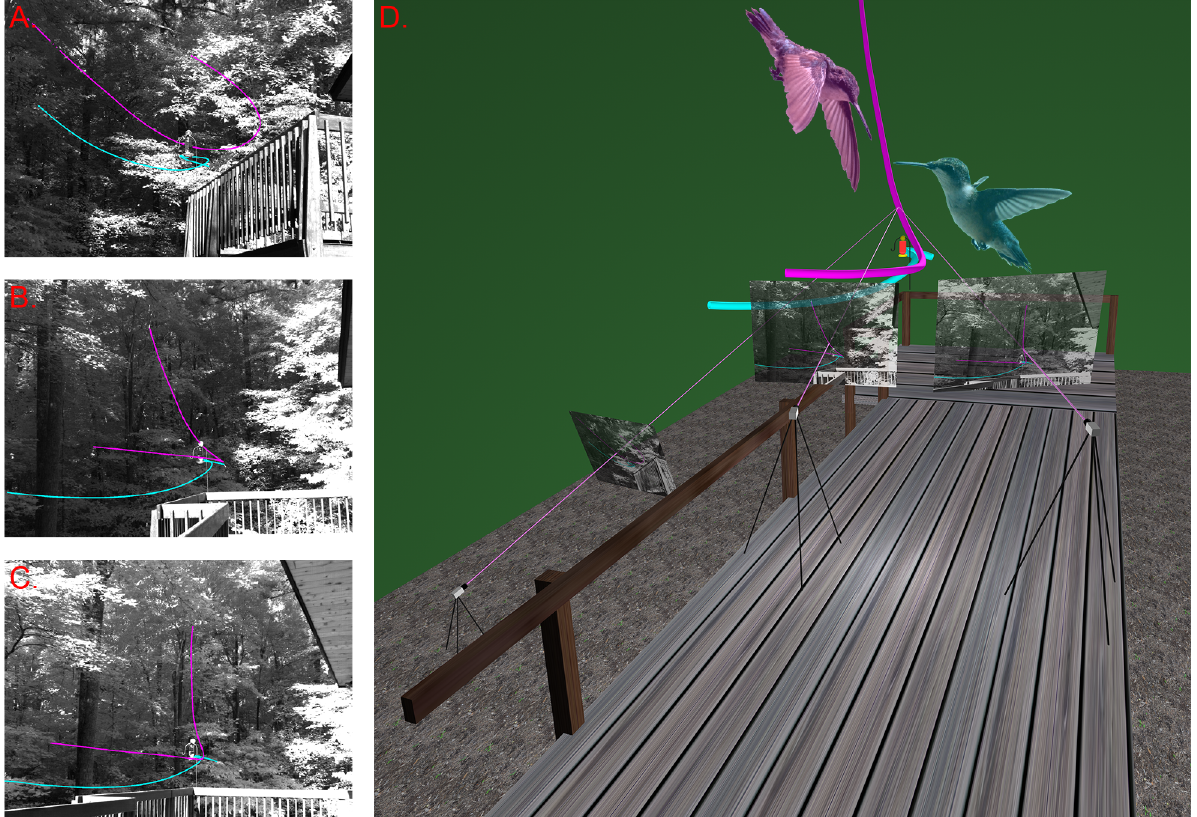
Fig 1. Video recording setup and example flight trajectories. Panels A-C show images from each of the three cameras in a recording setup; panel D shows a reconstruction of the 3D scene including the cameras, their positioning, their individual 2D images of the scene, the trajectory of the two hummingbirds in the 2D images as well as the 3D scene and triangulation rays identifying the 3D location of one bird at one instant from the 2D image information. The defending bird information is magenta while the chased bird is cyan; photographs (not to scale) of a defending and chased bird are included to show typical flight posture at the start of the interaction. Photo credit: Ellis